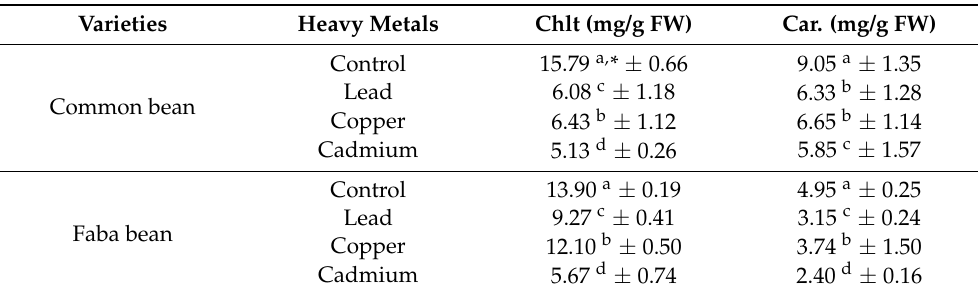
Table 2. Mean effect (mean ± SD) of HMs on total chlorophyll and carotenoids evaluated at the full vegetative stage of bean and faba bean